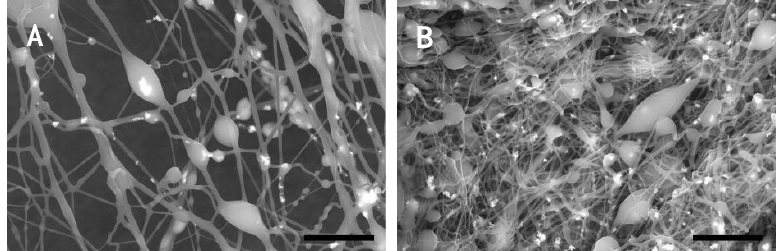
Figure 5. SEM images of ( A ) the optimized MI beaded fibers and ( B ) the control beaded fibers fabricated at 8000×. Scale bar is 10 µm.